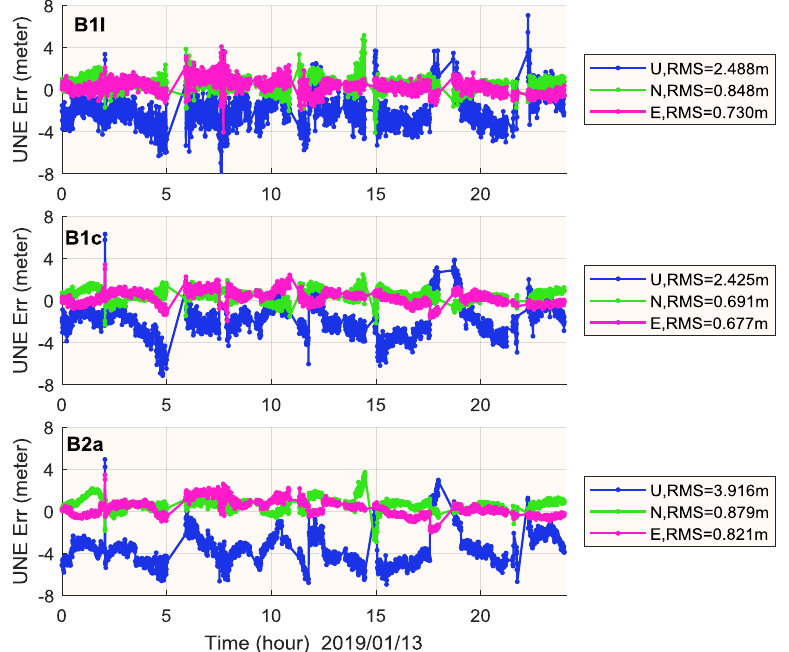
Figure 12. SPP comparison of B1I(upper), B1c (middle) and B2a (lower) at station BSHM (BDS-3 only).